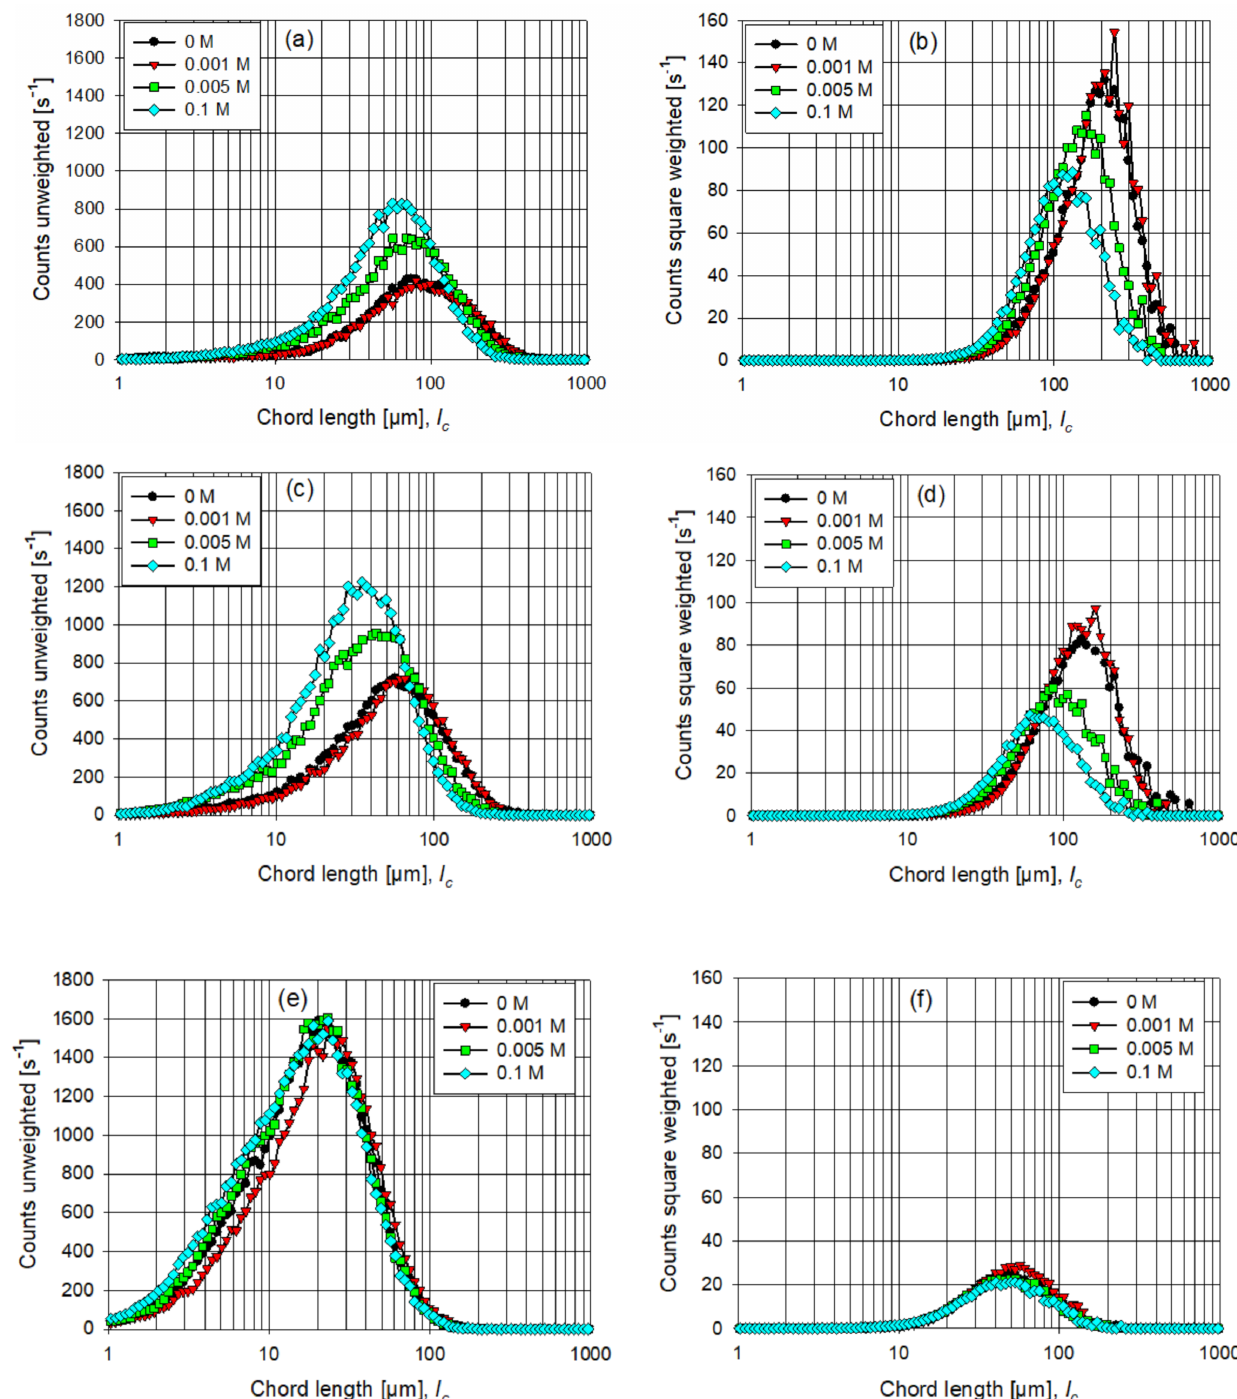
Figure 8. Unweighted (left column) and squared-weighted (right column) kaolin cord length distributions in saline solutions (NaCl). The distributions were measured 20 s after increasing the initial agitation of the flocculation process. The first row, ( a , b ), corresponds to the base case at G = 273 s − 1 , the second row, ( c , d ), at G = 502 s − 1 (G = 229 s − 1 increment), and the third row, ( e , f ), at G = 1789 s − 1 (G = 1516 s − 1